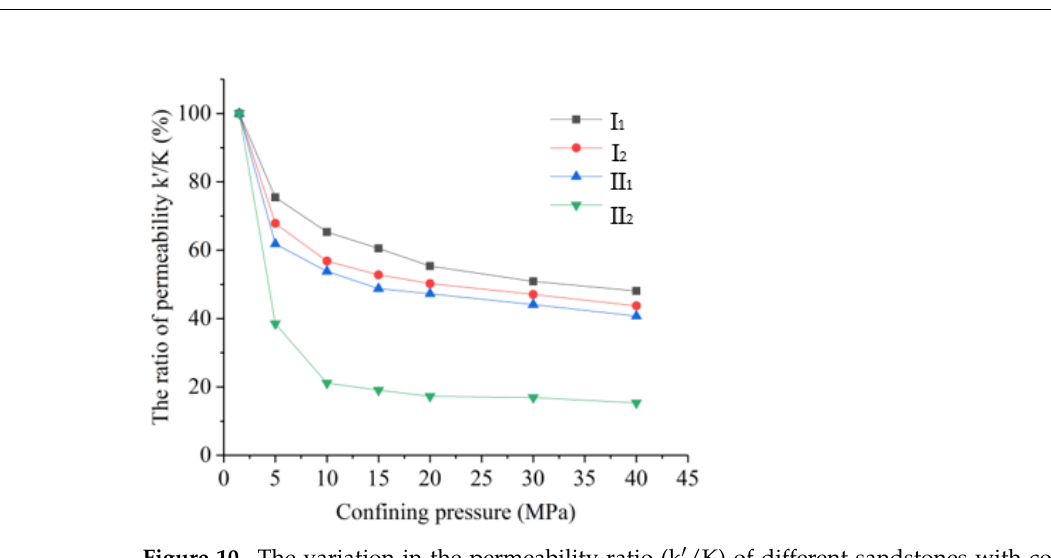
Figure 10. The variation in the permeability ratio (k ′ /K) of different sandstones with confining pressure.